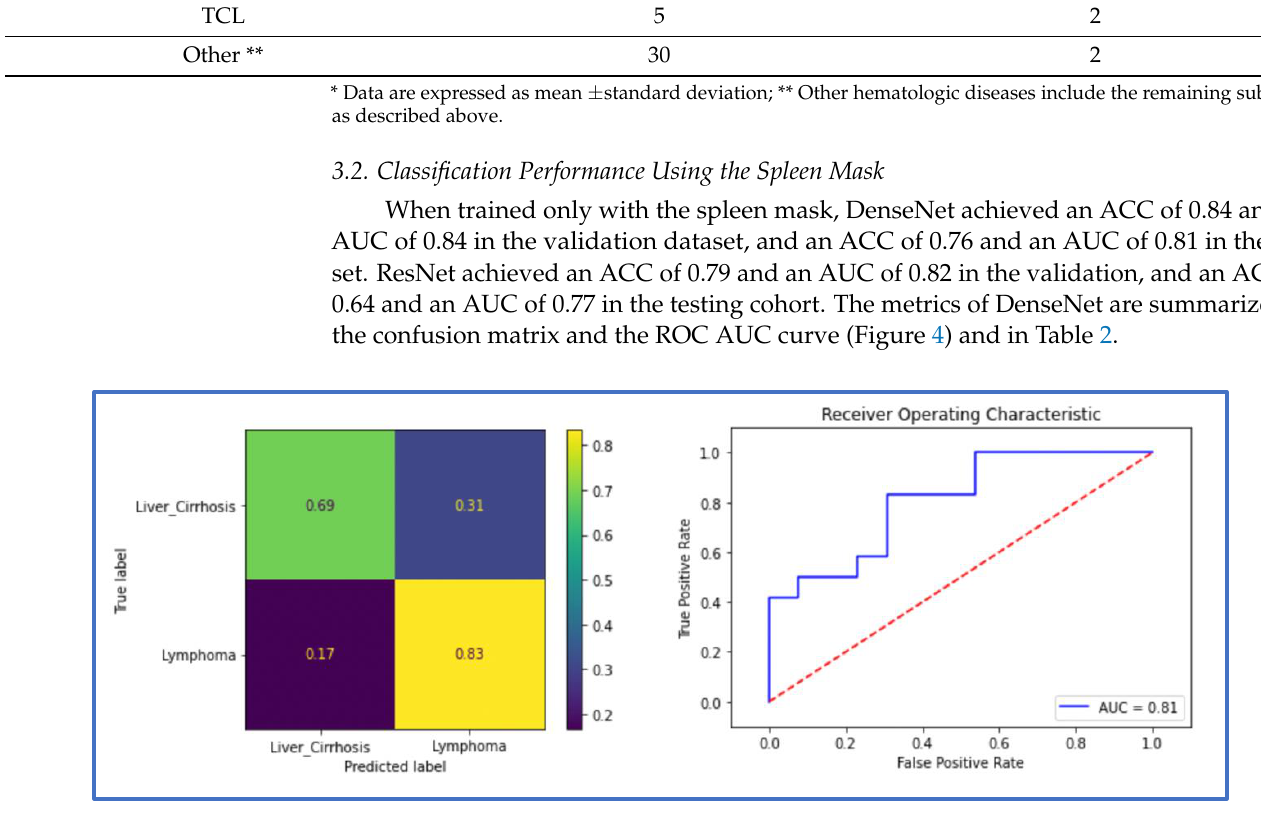
Figure 4. The receiver operating characteristic (ROC) curve and the confusion matrix of the classification model in the testing cohort using the spleen mask (Dense-Spl). Table 2. Metrics of the two models. AUC = area under the curve. ACC = accuracy. SEN = sensitivity. SPE = specificity.